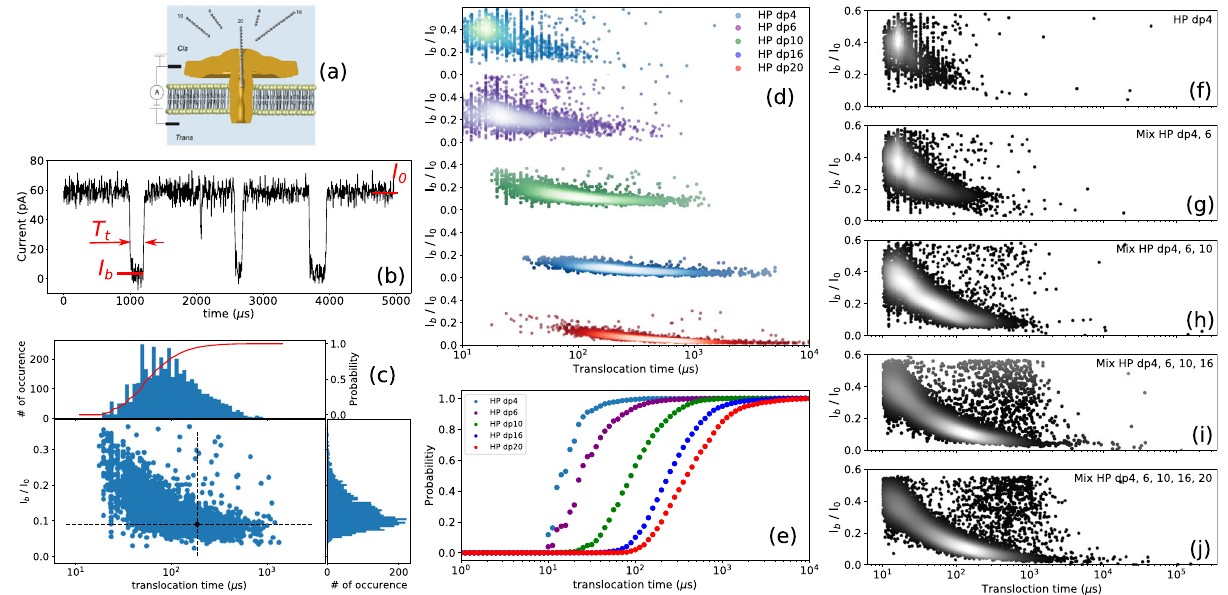
Fig. 2 | Single-channel detection of heparin (HP) oligosaccharides in the dpn range between tetrasaccharide dp4 and icosasaccharide dp20 (dpn, n =4-20) analyzed individually and in mixture by successive introduction of HP oligo- saccharides into the cis compartment. a Schematics of the experimental setup withaerolysininsertedinalipidbilayer(nottoscale).Theioniccurrentisrecorded while applying a constant voltage. b Illustration of typical single nanopore current recording in presence of HP dp10. The current is blocked by the presence of the molecule inside the channel (translocation). For each translocation event the blocked current I b , the open pore current I 0 and the duration of event T t are cal- culated. c Scatter plot for HP dp10 with the associated current histogram, trans- location time histogram with logarithmic binning and the corresponding integrated probability (red curve and right axis). The black dot represents the fi rst event representedon b . The distortion of the event cloud at short timescale is due to the signal distortion from the low-pass fi ltering of the signal. d Scatter plots obtained for different sizes of HP oligosaccharides when they were analyzed